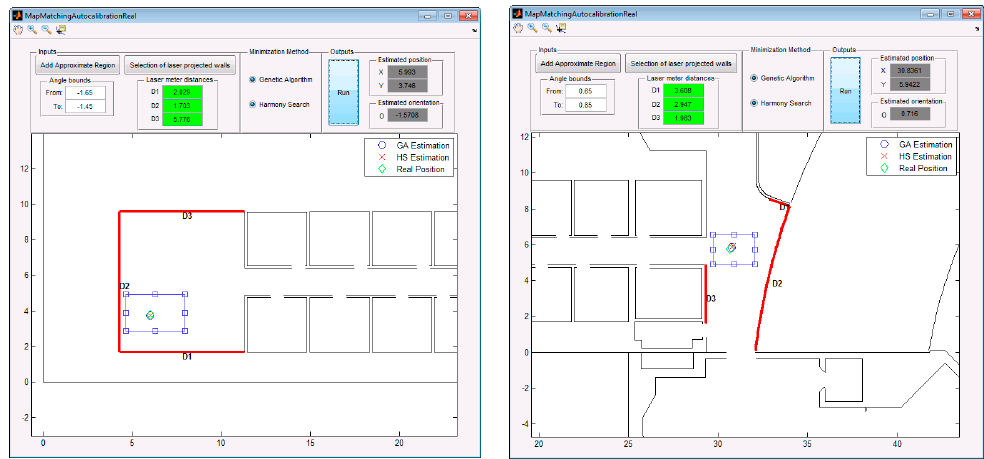
Figure 10. Real data included in the developed GUI related to a single position estimation for two placements of beacons (beacon #1 on the left and beacon #2 on the right) in two different environments (same as those used for simulation in Figure 7).